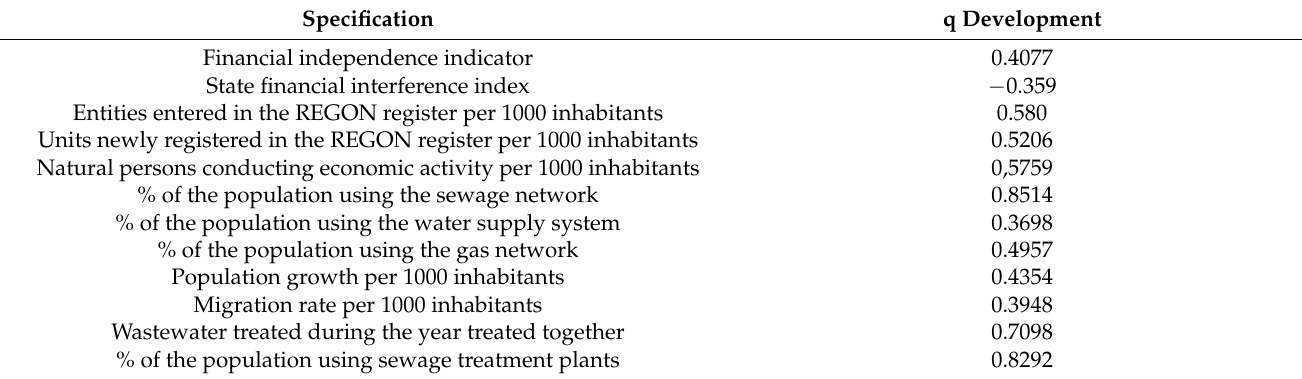
Table 5. Correlation between the financial situation and development measures and socio-economic variables in rural communes of eastern Poland (co. Pearson;